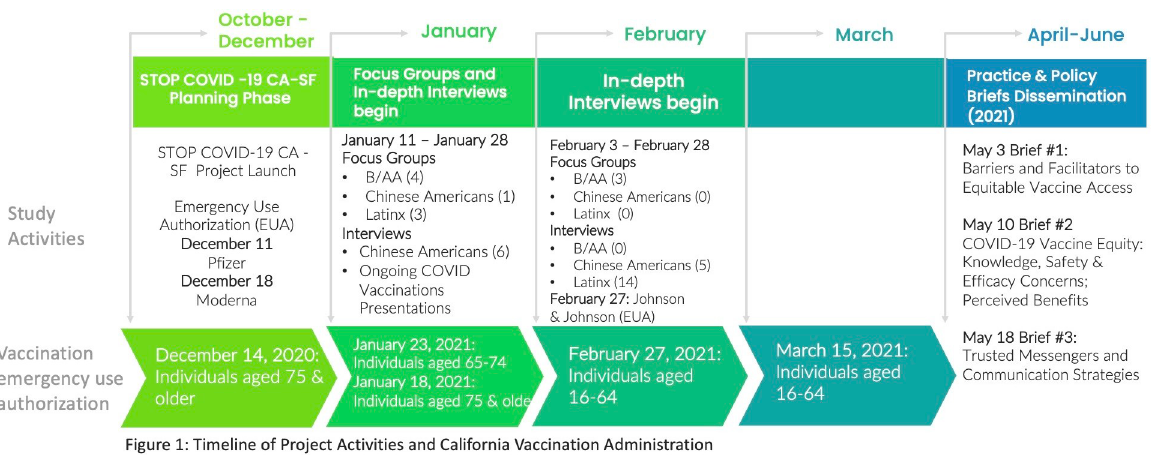
Fig 1. Timeline of project activities and California Vaccination